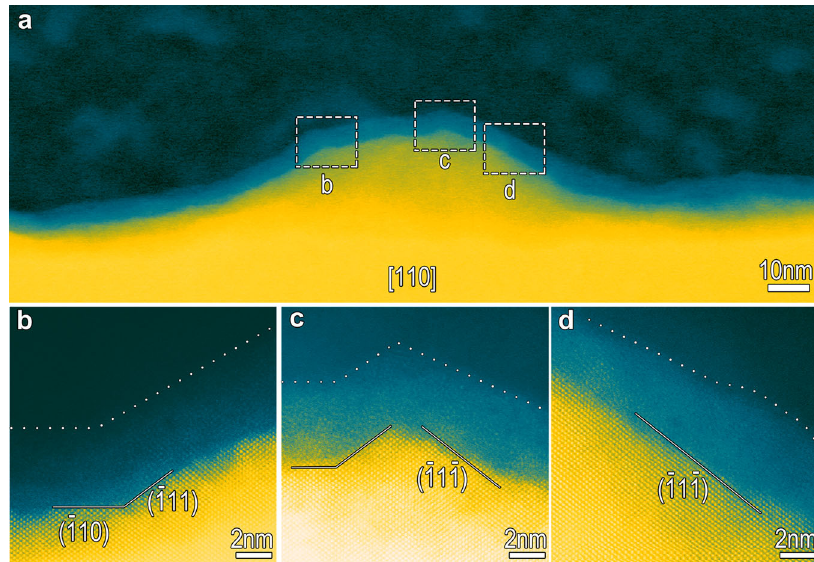
Fig. 3 HRHAADF-STEM images showing transpassivation-induced prevalence of the interfaces composed of {111} close-packed planes. a HAADF- STEM image showing a convex position. b – d Zoom-in images show the high-resolution HAADF-STEM images of the three sites located at the top ( b , c ) and wall ( d ) of the convex, wherein some speci fi ed {111} close-packed planes are exposed.